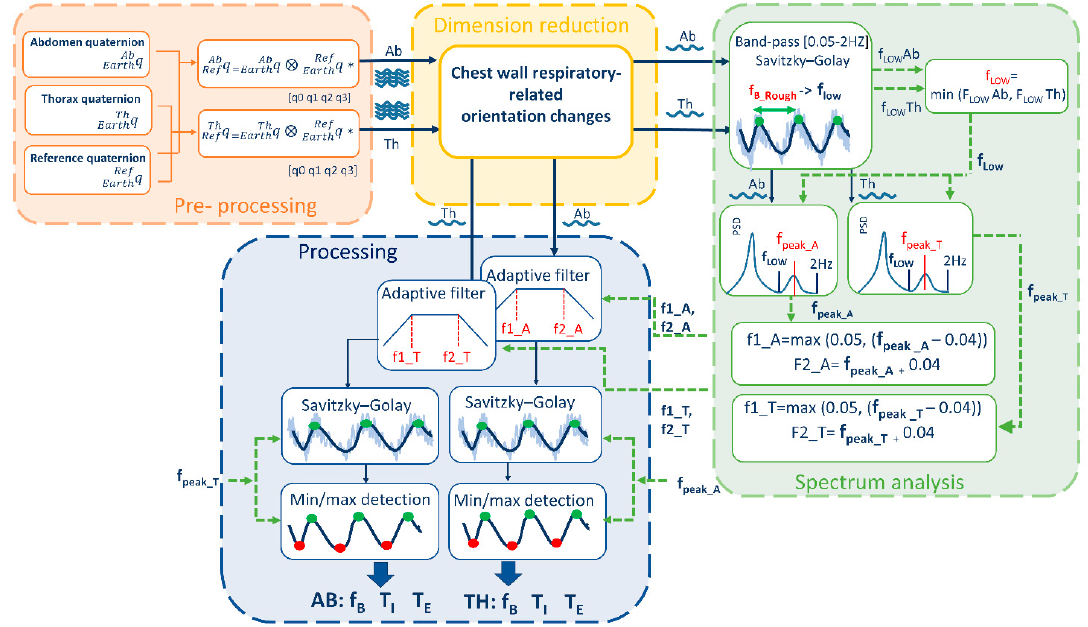
Figure 1. Block Diagram of the Analysis algorithm that allows derivation of breathing temporal parameters (f B . T I , T E ) from quaternion-based orientation change signals recorded on Thorax, Abdomen and Reference point.